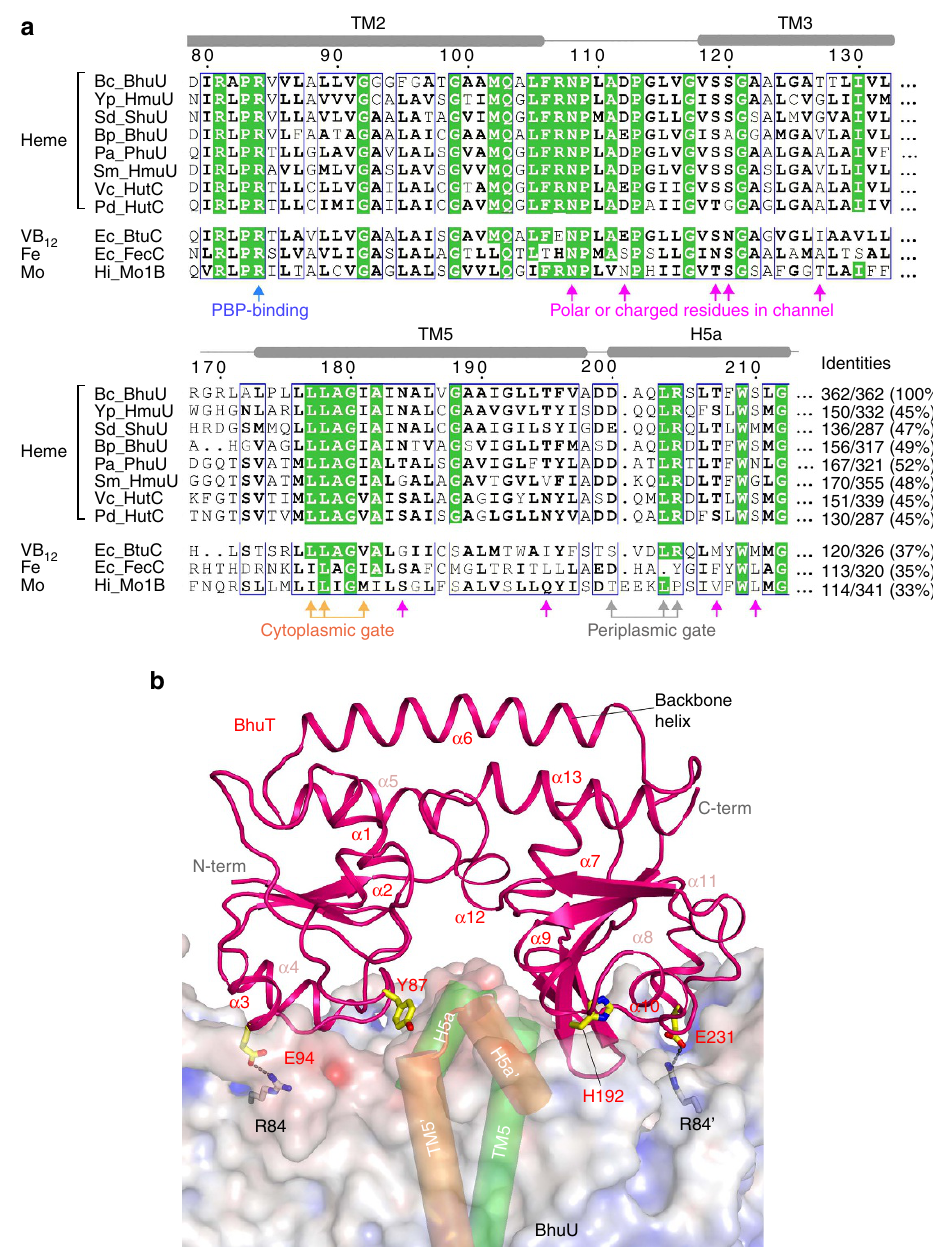
Figure 3 | Sequence conservation of the residues in the channel and PBP-TMD interface. ( a ) Sequence alignment of regions of TM2-TM3 and TM5-H5a in the haem importers, vitamin B 12 transporter, iron-chelate transporter and molybdate transporter. Bc, Burkholderia cenocepacia ; Yp, Yersinia pestis ; Ec, Escherichia. coli ; Sd, Shigella dysenteriae ; Bp, Bordetella pertussis ; Pa, Pseudomonas aeruginosa ; Sm, Sinorhizobium meliloti ; Vc, Vibrio cholerae ; and Pd, Photobacterium damselae ; Hi, Haemophilus influenza . GenBank accession numbers are listed in Online Methods. ( b ) Interface between BhuT (magenta ribbon) and dimeric BhuU (surface representation) in the crystal structure of the BhuUV-Tcomplex. The N- and C-terminal domains of BhuTare bound in the groove above the BhuU dimer. The haem-binding pocket of BhuT is partially occupied by the two H5a helices of the BhuU dimer. The conserved residue pairs (R84–E94 and R84–E231) for salt bridge formation at the interface are shown as stick models. Y87 of BhuT is the ligand for